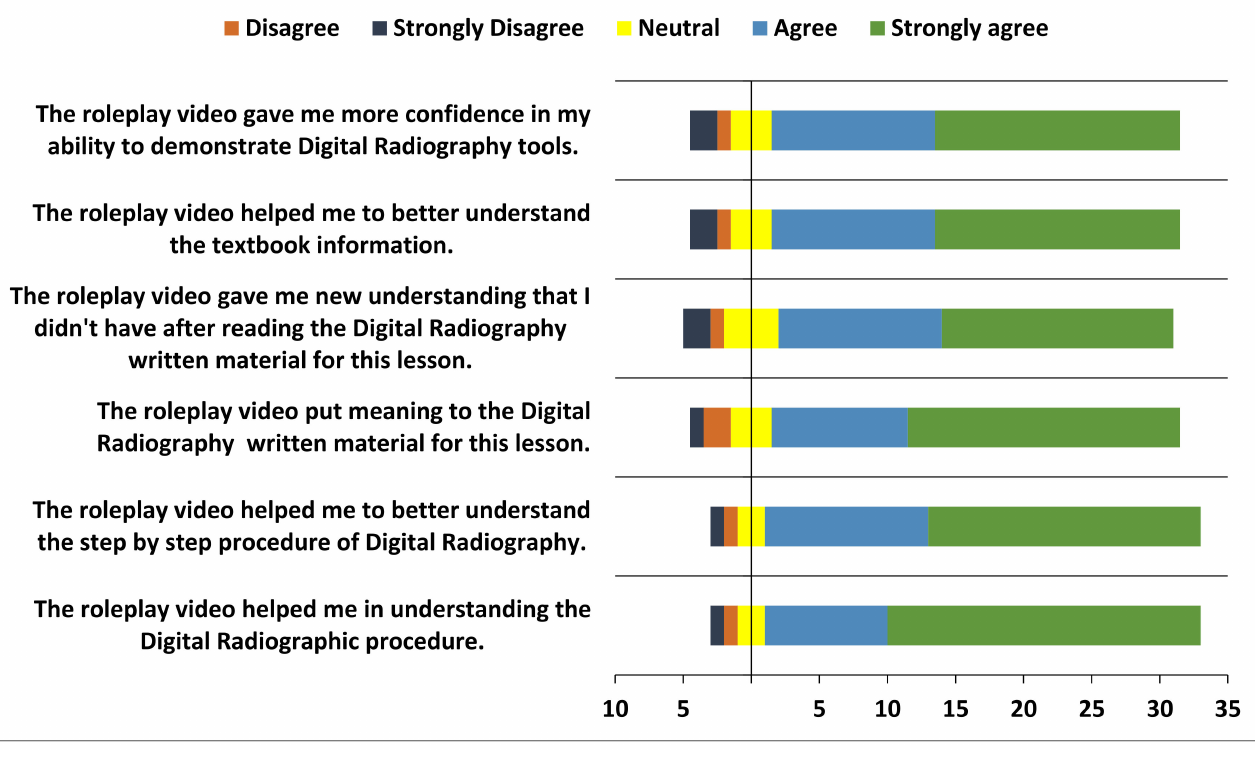
Figure 3. Responses of the participants towards roleplay soft skills in Radiology discipline. A comparison of participant feedback responses across the three disciplines revealed no significant difference ( p > 0.05) in responses to all items, indicating no differences in the rating response between disciplines. Roleplay, as a teaching tool for video production and soft skill development, was unaffected by the type of discipline, as all three disciplines were rated highly by the participants (Table